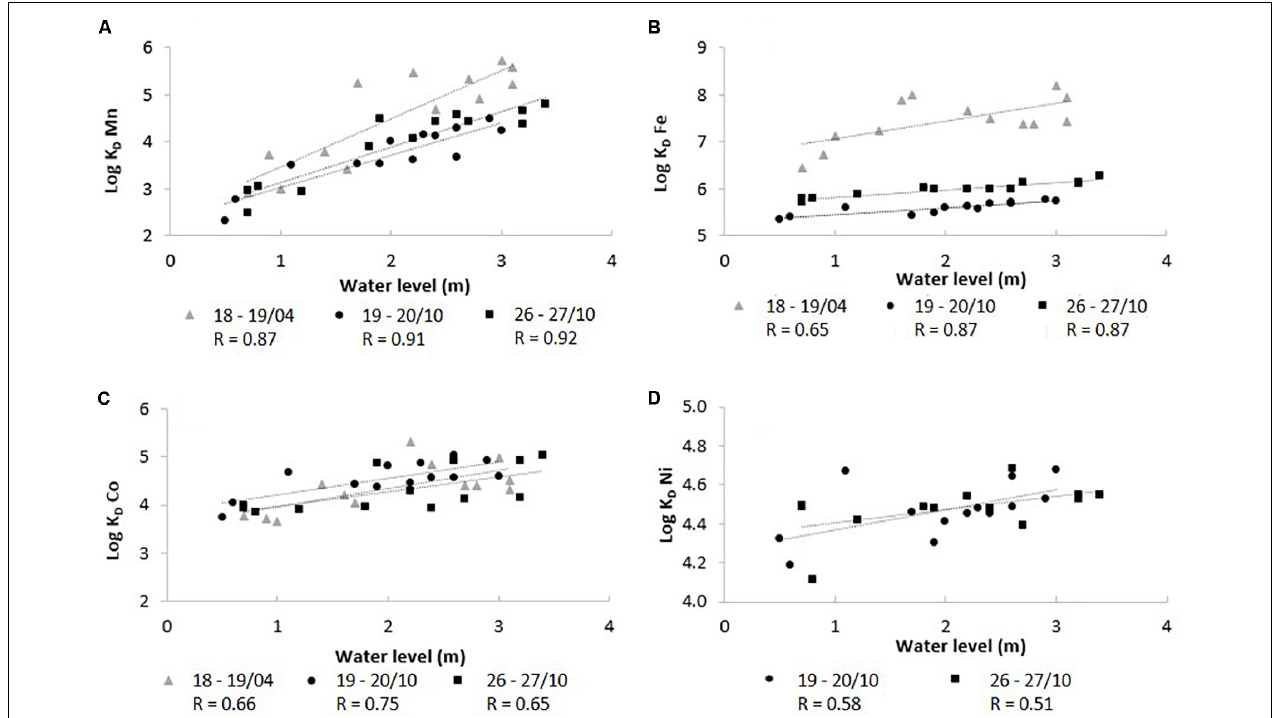
FIGURE 5 | Correlations between Log K D of trace metals and water level for all tidal cycles in the creek during the dry (gray dots) and the wet seasons (black